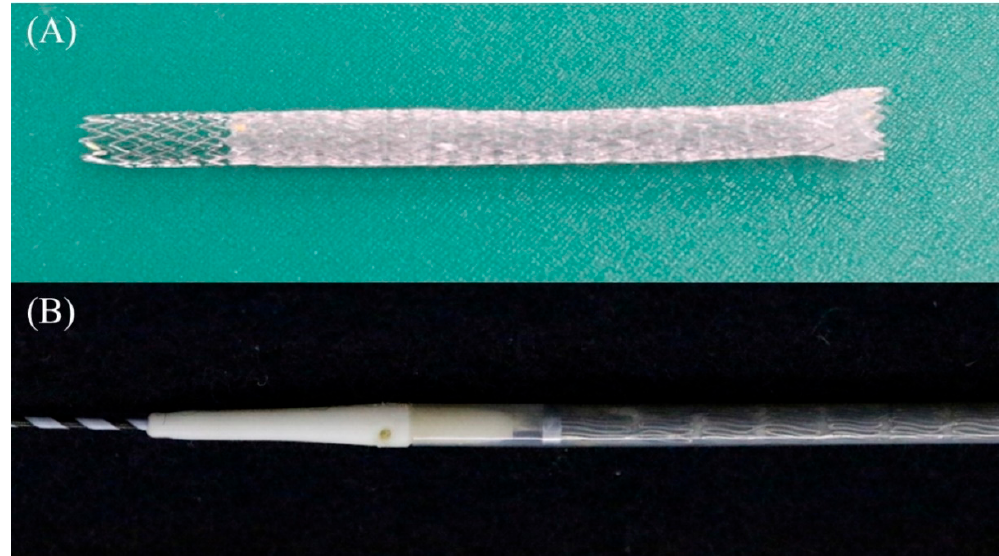
Figure 19. Covered BileRush Advance (Piolax Medical Device). The partially covered laser-cut stent of 8 × 120 mm in size with a 2 cm uncovered portion on the hepatic end ( A ). The slim introducer with a 7 Fr shaft and 2.4 Fr tip ( B ). (Courtesy of Piolax Medical Device).